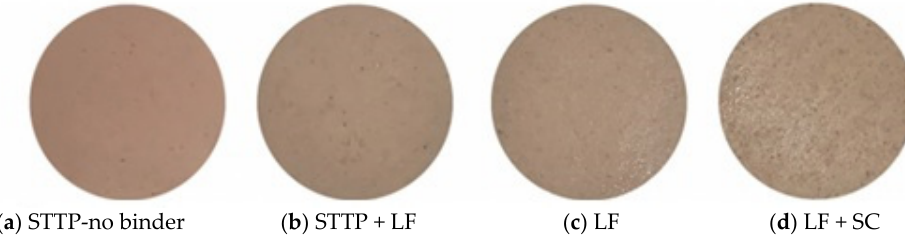
Figure 7. Cross-sectional view of cooked chicken bologna. ( a ) STPP-no binder: 0.3% sodium tripolyphosphate only; ( b ) STPP+LF: 0.3% sodium tripolyphosphate +6% lentil flour; ( c ) LF: 6% lentil flour; and ( d ) LF+SC: 6% lentil flour + 0.6% seed coat. (Reprinted with permission from Pathiraja [81]).